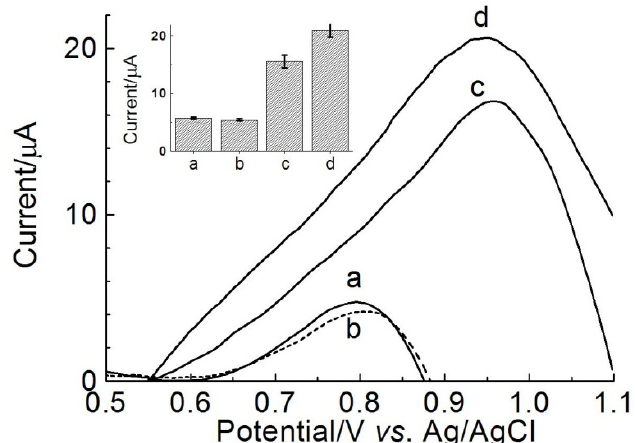
Figure 4. Differential pulse voltammograms of ethidium bromide (1 × 10 − 6 mol·L − 1 ) onto graphite electrode modified with poly(4-ATP) prepared in pH 0.5 (baseline-corrected), 100 scans, containing EBV1/probe (126 µmol·L − 1 ) before hybridization (a) and after hybridization with: non-complementary target (189 µmol·L − 1 ) (b); oligonucleotide containing one-base mismatch EBV2Mis1 (378 µmol·L − 1 ) (c); and complementary target (EBV2, 378 µmol·L − 1 ) (d). Electrolyte: phosphate buffer (0.10 mol·L − 1 ), pH 7.4. Modulation amplitude: 25 mV. Pulse interval: 0.2 s; Scan rate 20 mV·s − 1 . Inset: Bar chart of differential pulse voltammograms responses using the oxidation signal from ethidium